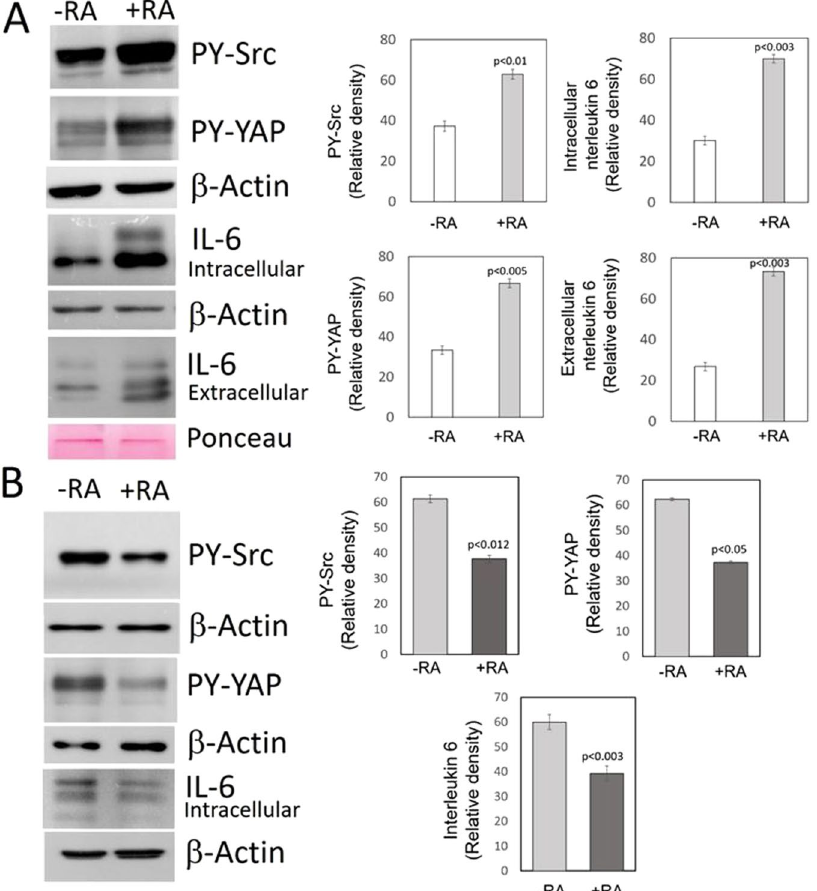
Figure 1. Effect of RA on the Src-YAP-IL6 axis in triple-negative MDA-MB-231 and MDA-MB-468 breast cancer cells. MDA-MB-231 and MDA-MB-468 breast cancer cells were incubated for two days in the absence (-RA) or presence ( + RA) of retinoic acid (5 μ M). ( A ) Western blots of MDA-MB-231 cells show the increase in tyrosine phosphorylation of Src and YAP determined in nuclear extracts and the increase of IL-6 expression assessed in cell lysates and the culture medium. The bar graphs show quantification of data from three independent experiments. β -Actin and Ponceau staining were used as loading controls. ( B ) Western blots of MDA-MB-468 breast cancer cells show the decrease in tyrosine phosphorylation of Src and YAP determined in nuclear extracts and the decrease of IL-6 expression assessed in cell lysates. The bar graphs show quantification of data from three independent experiments. β -Actin was used as loading control. Full-length figures of the cropped blots are in Supplementary Figures